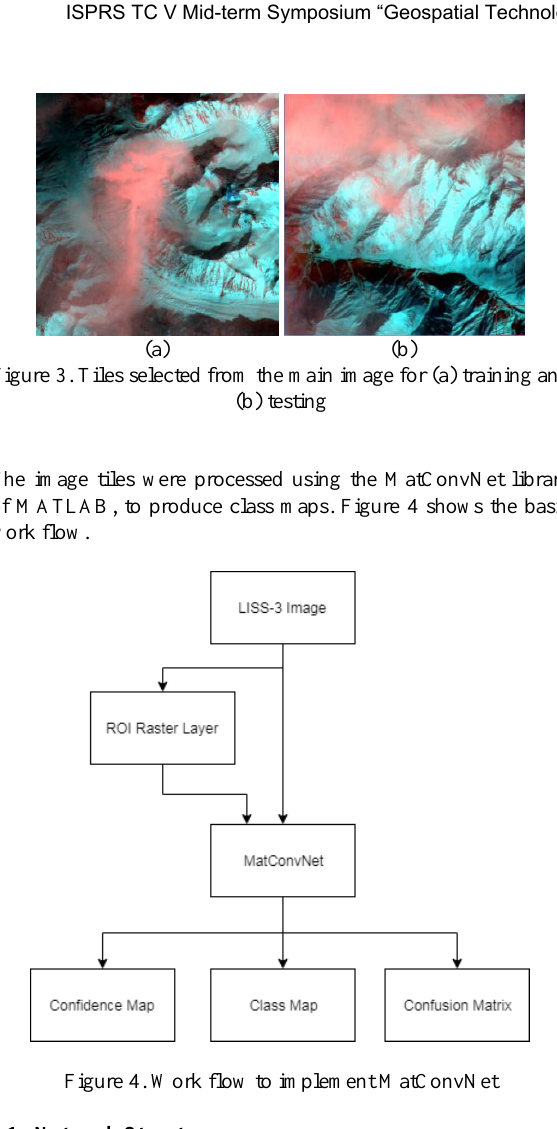
Figure 4. Work flow to implement MatConvNet